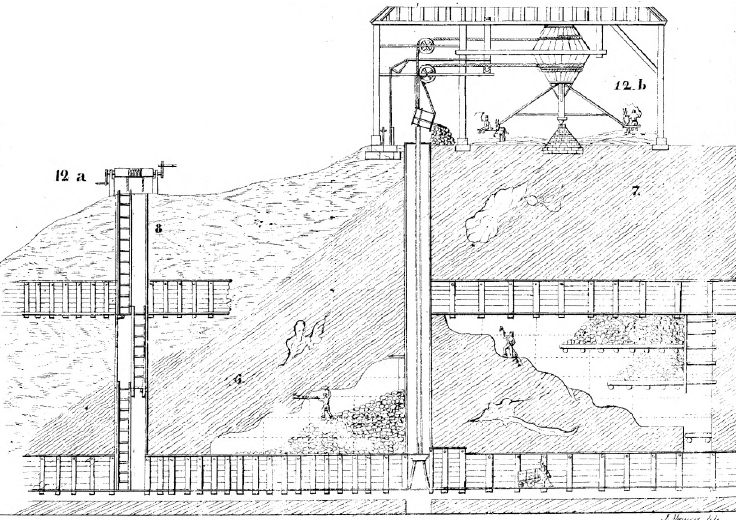
Figure 1. The treadmill mine (first half of the 19th century)